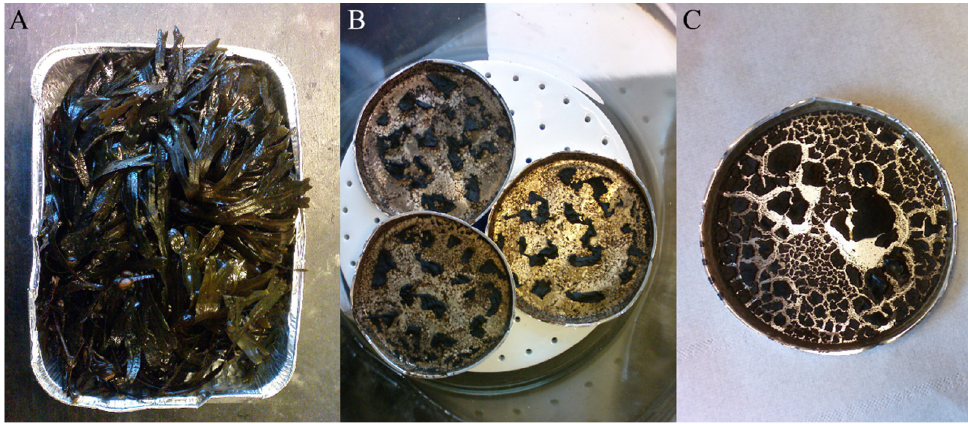
Figure 7. Physical appearance of the samples: fresh biomass ( A ), dried alginate extraction residues ( B ), and dried fucoidan extraction residues ( C ).